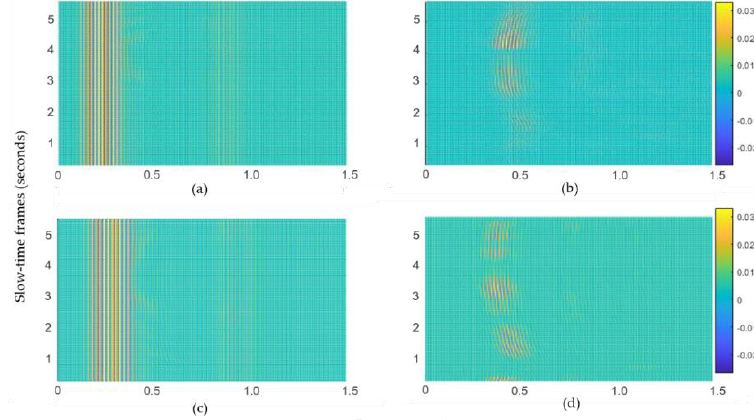
Figure 13. Patterns of recorded gestures for a 5.5 s duration: ( a ) Gesture-1 before and ( b ) after the clutter removal operation. ( c ) Gesture-2 before and ( d ) after the clutter removal operation.